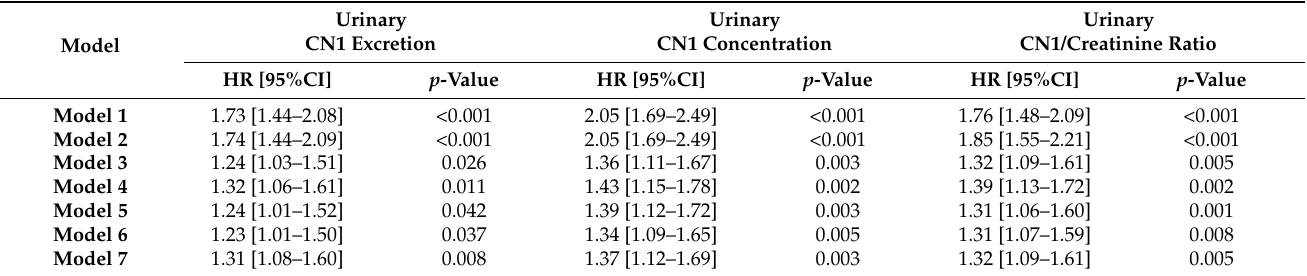
Table 4. Prospective association of urinary CN1 with risk of graft failure in